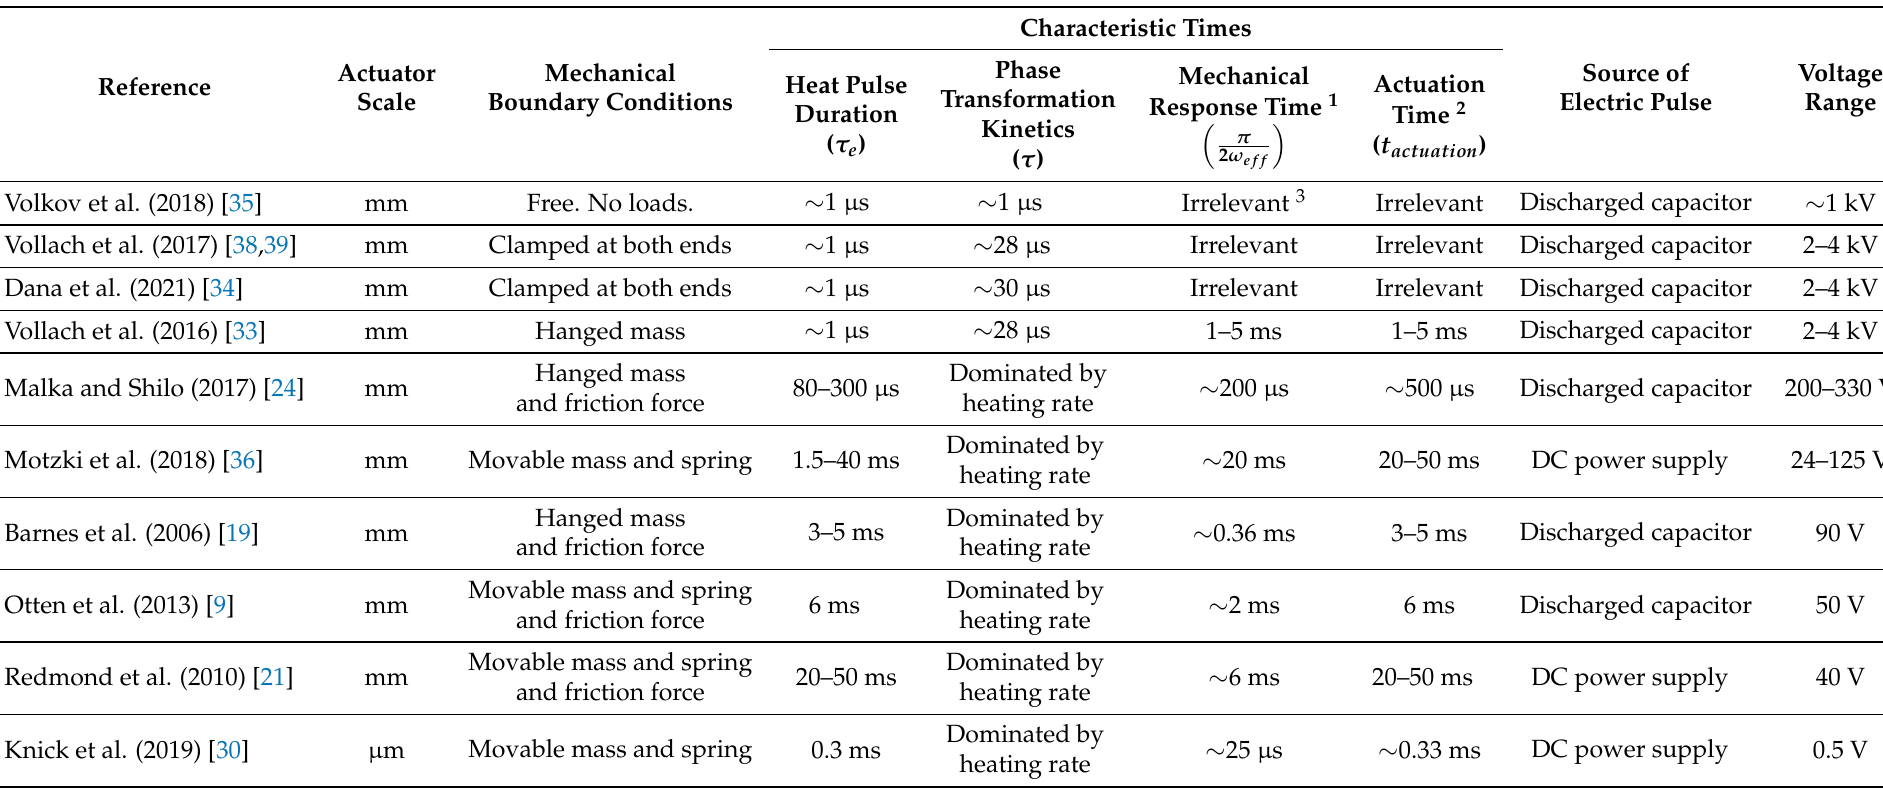
Table 1. Comparison of a selection of previous studies of the thermo-mechanical response of SMA wires under electric pulse heating with respect to heat pulse duration, power source and boundary